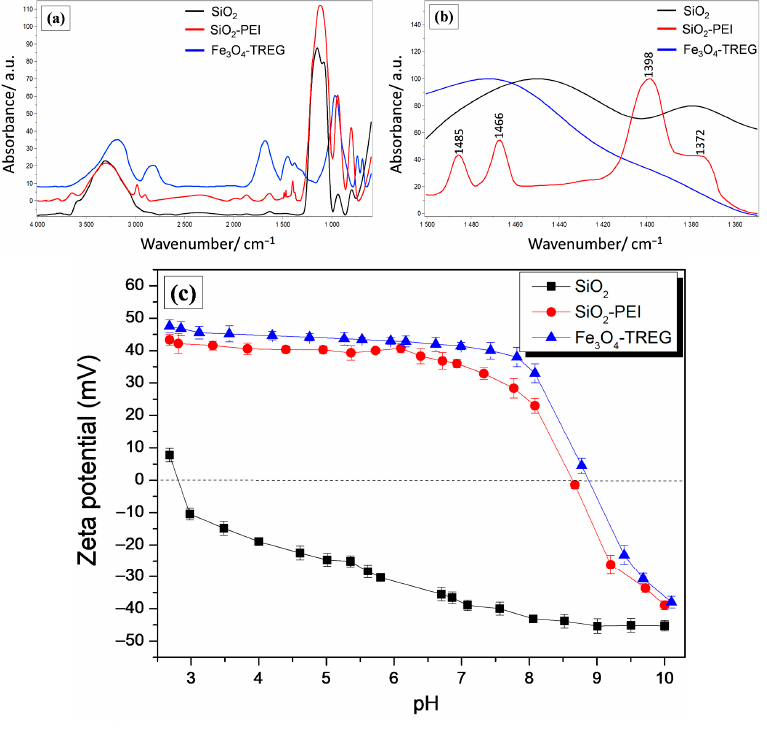
Figure 4. FT-IR spectra of bare SiO 2 (black line), PEI functionalized SiO 2 particles (red line) and TREG-modified Fe 3 O 4 NPs at the spectral region ( a ) from 4000 cm –1 to 600 cm –1 , and ( b ) from 1500 to 1350 cm –1 ; ( c ) mean zeta potential as a function of pH for SiO 2 , SiO 2 -PEI and Fe 3 O 4 -TREG NPs.